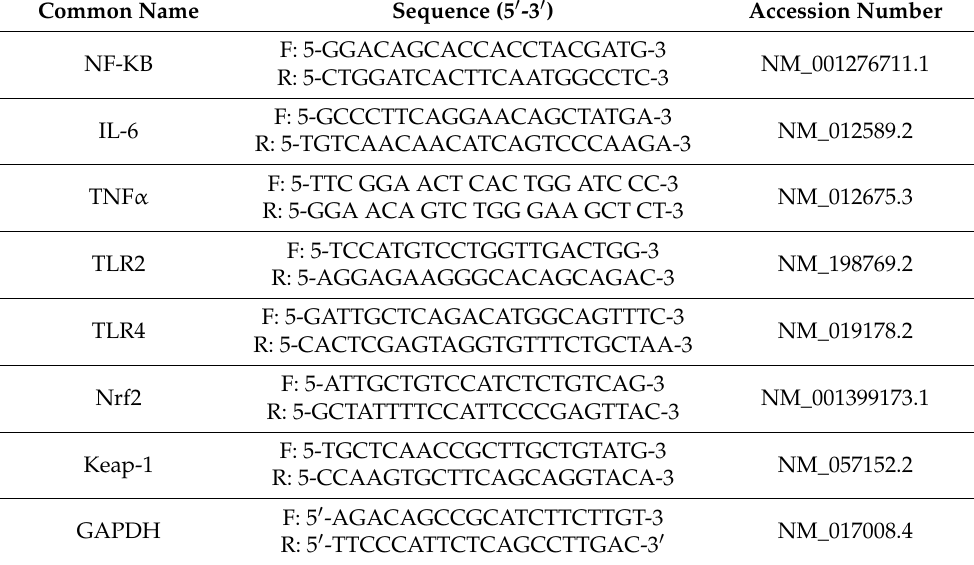
Table 1. Primers used for quantitative